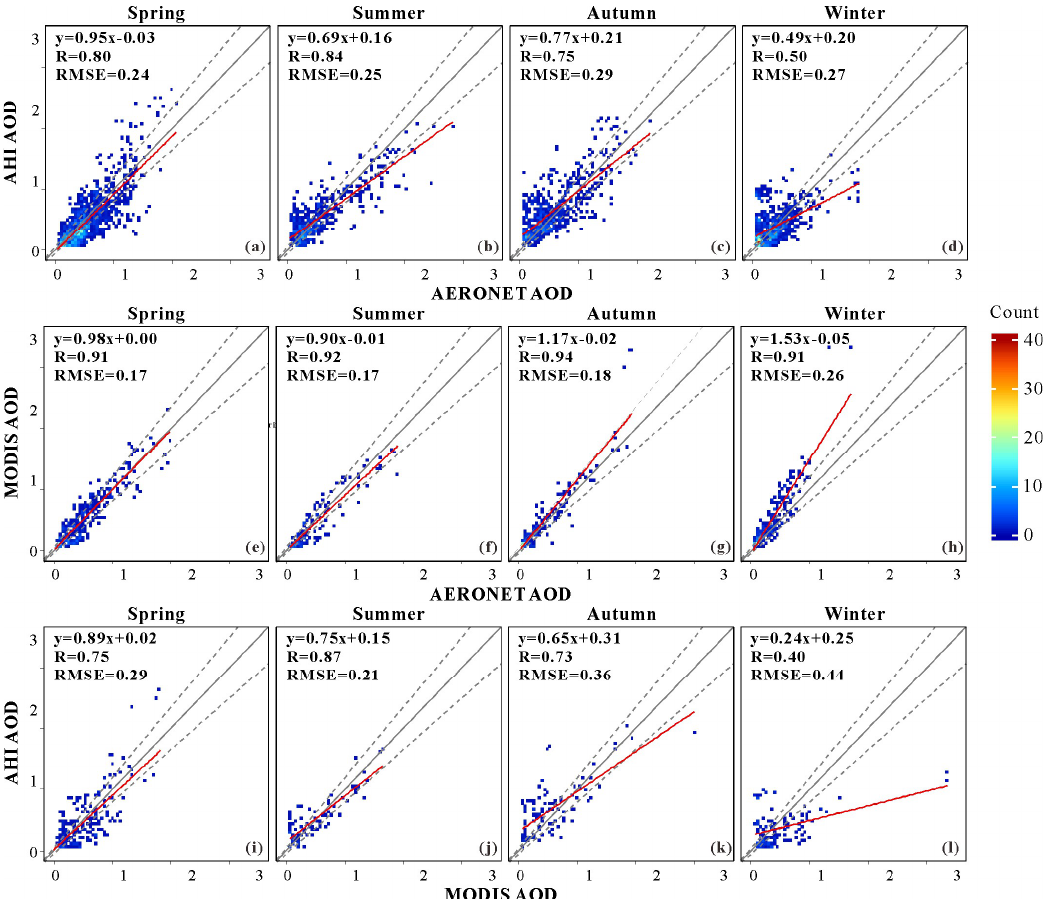
Figure 8. AHI ( a – d ) and MODIS ( e – h ) against AERONET AOD, and AHI against MODIS ( i – l ) for